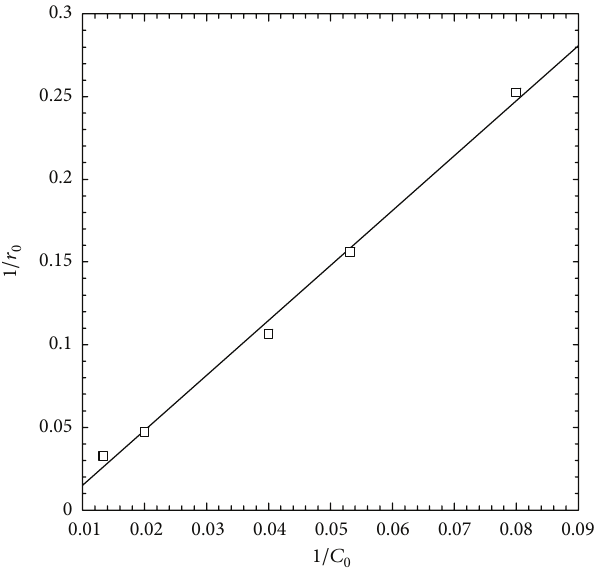
Figure 8: Langmuir-Hinshelwood kinetic model (ZnO loading dosage of 60 gm −2 with light intensity of 2.1mWcm −2 ).